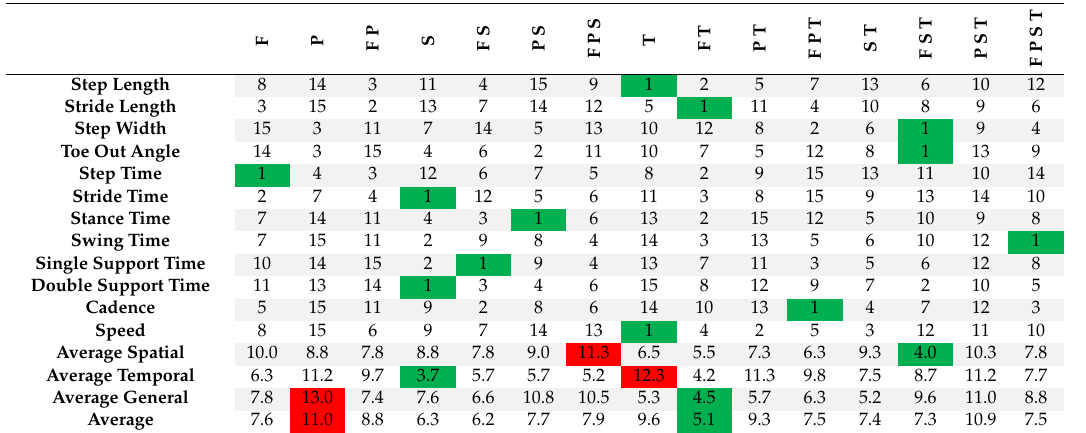
Table 5. Sensor combinations ranking based on mean NAPE.